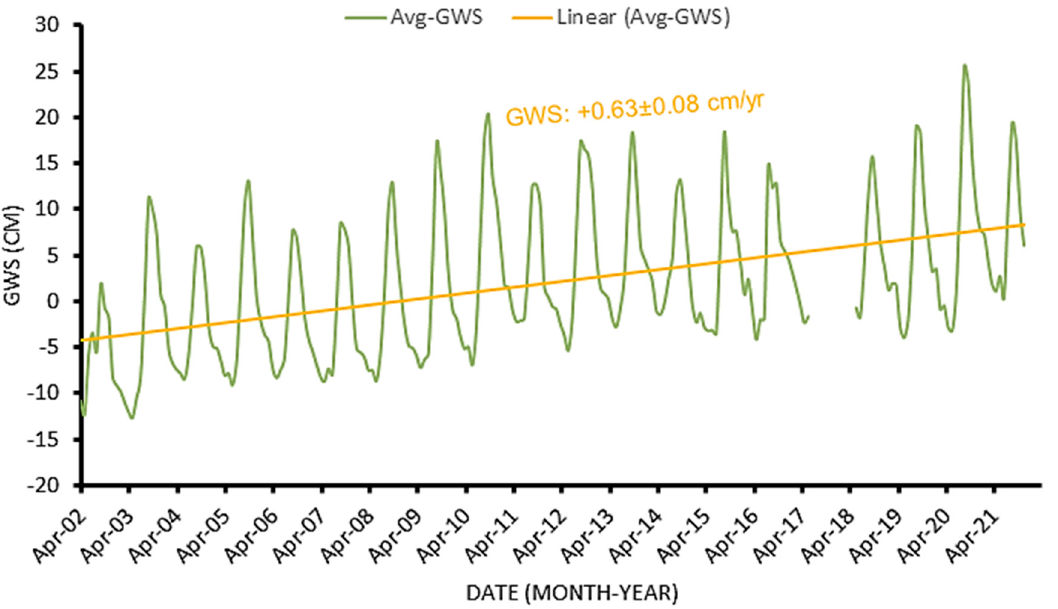
Figure 7. Monthly variation of the Avg-GWS in the Senegalese territory.